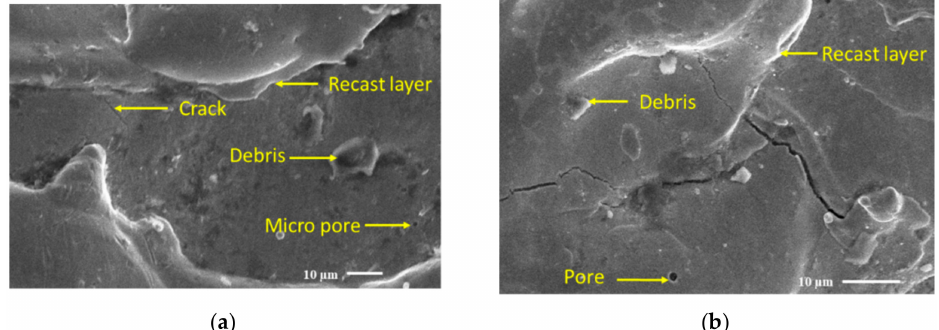
Figure 12. Variation of surface morphology with T off (I p , V g , T on , T off , P) ( a ) (7, 60, 300, 25, 16); ( b ) (7, 60, 300, 45, 16); units as per Table 2.